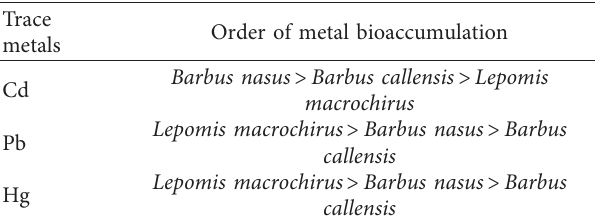
Table 7: The order of the bioaccumulation of trace metals in the muscles of the studied fish